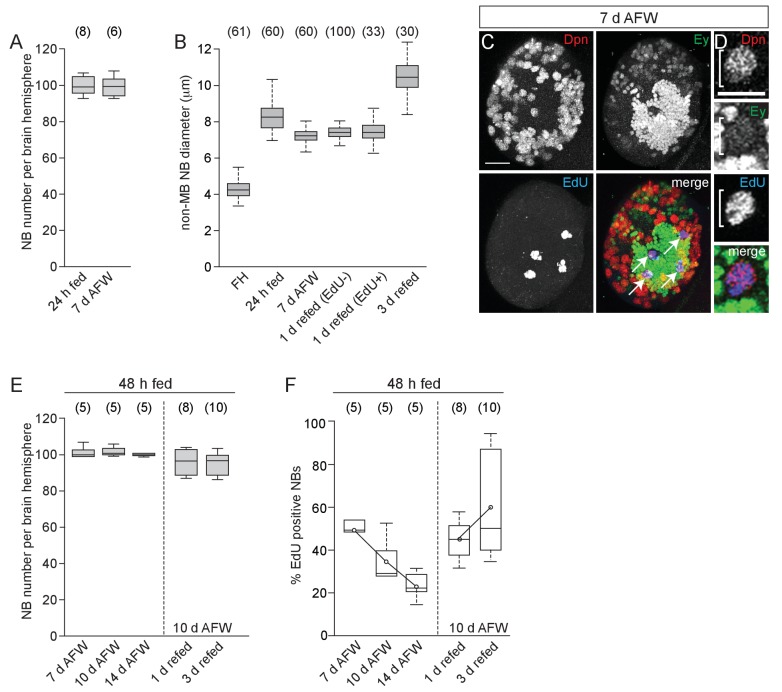
Dietary nutrients are required for NB proliferation but do not affect NB number.(A) Box plot of the number of Dpn-positive NBs in individual brain hemispheres at the indicated time points. Numbers in parentheses indicate number of brain hemispheres analyzed. (B) Box plot of non-MB NB diameter at the indicated time points. One day refed NBs are broken into those incorporating EdU and those not. Numbers in parentheses indicate number of non-MB NBs scored. (C) Maximum intensity projection of a control brain hemisphere showing Ey expression in the four MB NBs (arrows) at 7 d AFW. (D) Single plane image of a control MB NB incorporating EdU at 7 d AFW. (E) Box plots of the number of Dpn-positive NBs in individual brain hemispheres from control larvae fed a complete diet for 48 hr, and then switched to sucrose-only for the indicated times. (F) Box plots of the percent EdU-positive NBs per brain hemisphere at the indicated time points after 48 hr of feeding. Scale bars: 20 µm, C; 10 µm, D.10.7554/eLife.26343.004Figure 1—figure supplement 1—source data 1.Quantification of NB number and cell size measurements in control brains fed 24 hr before dietary amino acid removal and refeeding.Also quantification of EdU-positive and Dpn-positive cells in control brains fed 48 hr before dietary amino acid removal and refeeding.